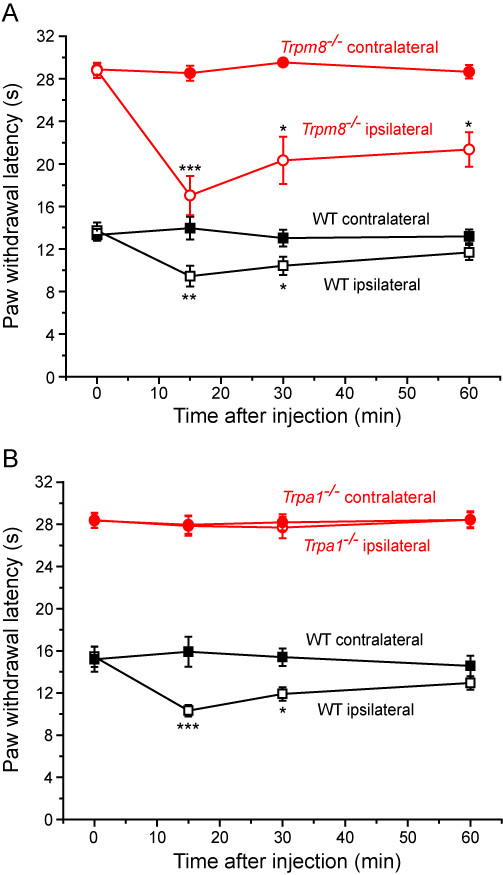
Menthol-evoked cold hypersensitivity is absent in Trpa1-/- mice but present in Trpm8-/- mice. A. Intraplantar administration of 25 mg menthol evoked marked cold hypersensitivity in the ipsilateral paw of lightly restrained Trpm8-/- mice. Note that a greater cold hypersensitivity was seen in Trpm8-/- than in wild-type mice. B. Menthol evoked cold hypersensitivity in wild-type but not Trpa1-/- mice. Data show mean ± SEM for 6 mice/group. * p < 0.05, ** p < 0.01, *** p < 0.001 vs relevant predose values. † p < 0.05, †† p < 0.01, ††† p < 0.001 for contralateral-ipsilateral difference in wild-type mice.